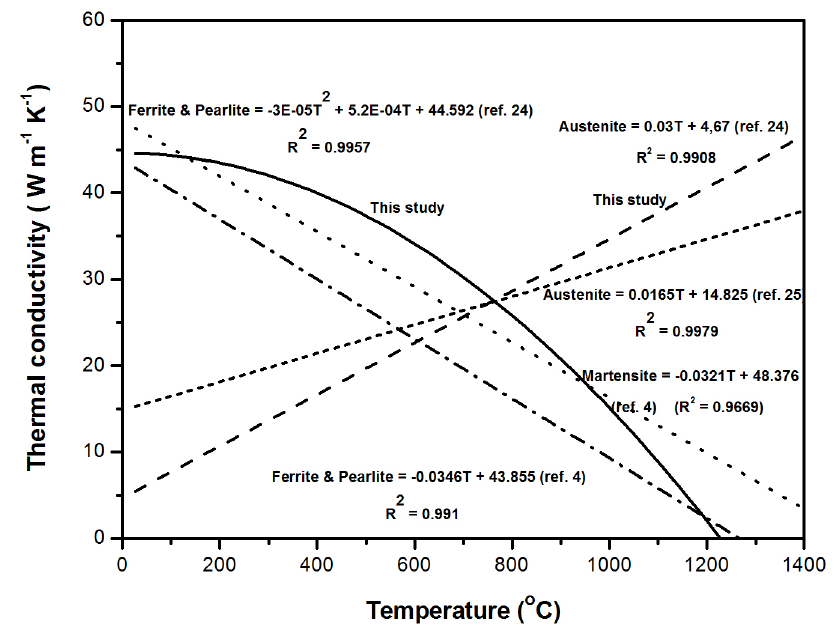
Figure 3 - Temperature-dependent thermal conductivity for the investigated steel and individual phases considered in this mode